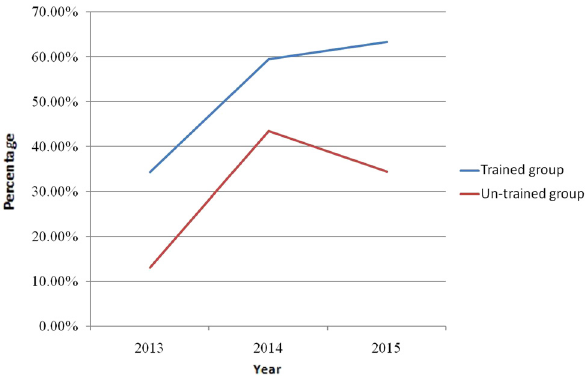
Figure 1: The rate of bone mineral density test in the patients with hip fracture intrained group and untrained group between 2013 and